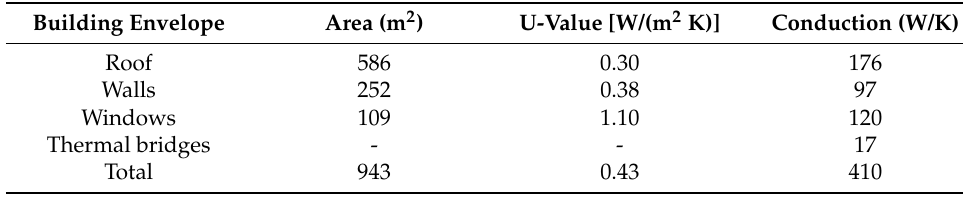
Table 1. Building envelope information of the studied building.